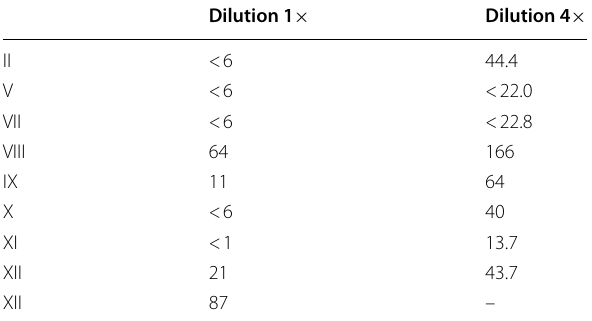
Table 3 Coagulation factor activity at the onset of